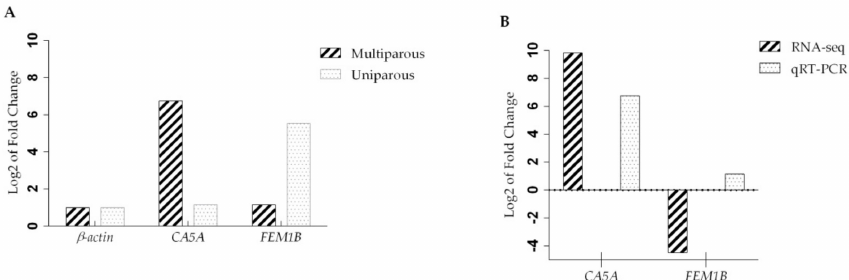
Figure 3. Validation of RNA-seq of CA5A and FEM1B genes by quantitative real-time polymerase chain reaction (qRT-PCR). ( A ) Gene expression profiles in ovarian tissue in multiparous and uniparous in Pelibuey sheep by qRT-PCR; ( B ) Expression level of the di ff erentially expressed genes detected by the RNA-seq and expression level of the di ff erentially expressed genes obtained by